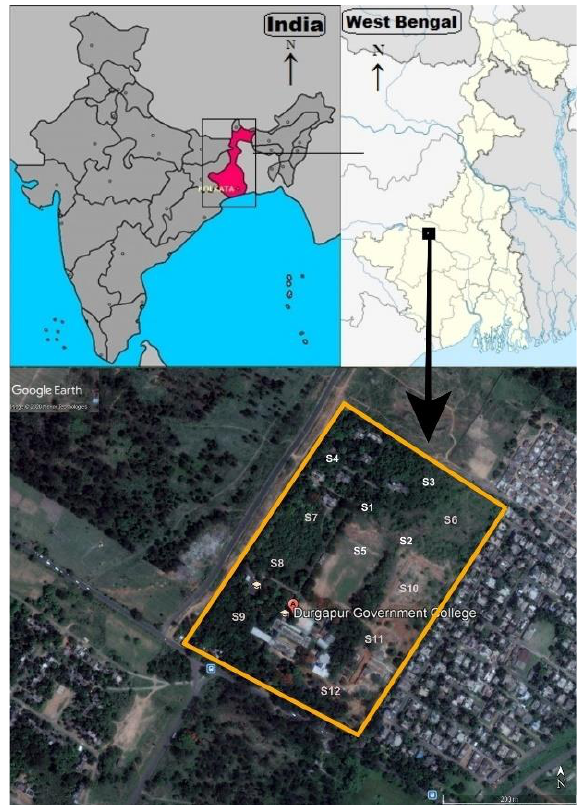
Figure 1. Location of the study site,